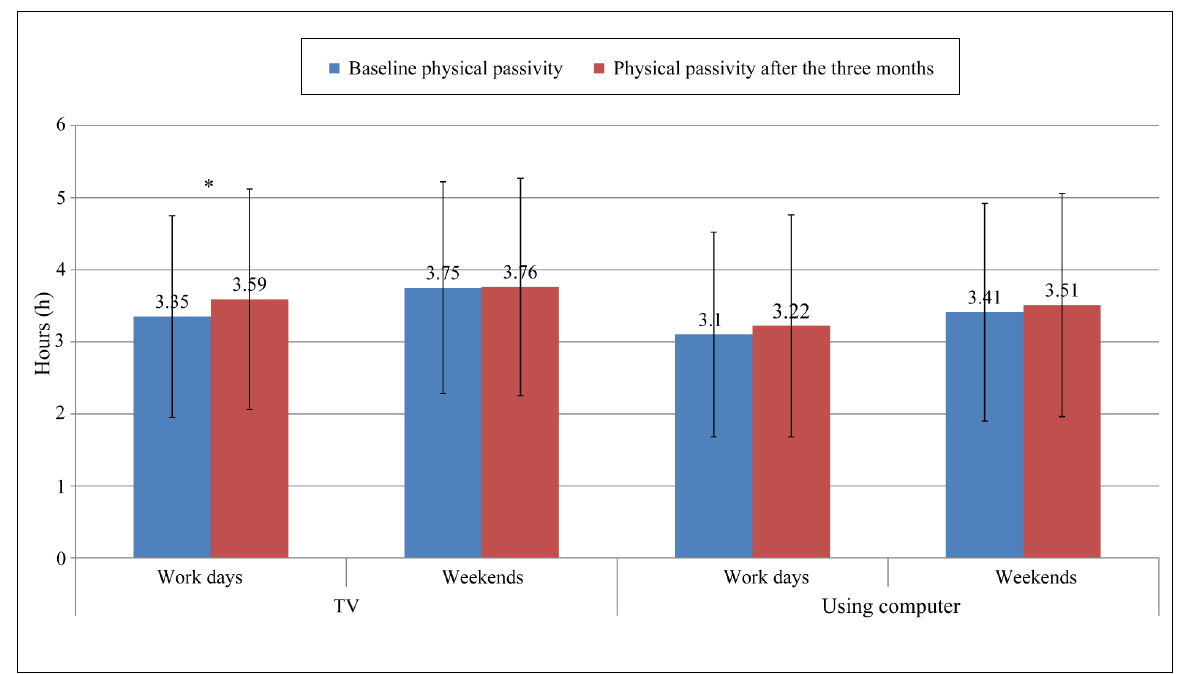
Figure 5. Changes in the sedentary behaviour of the control group in three months’ time